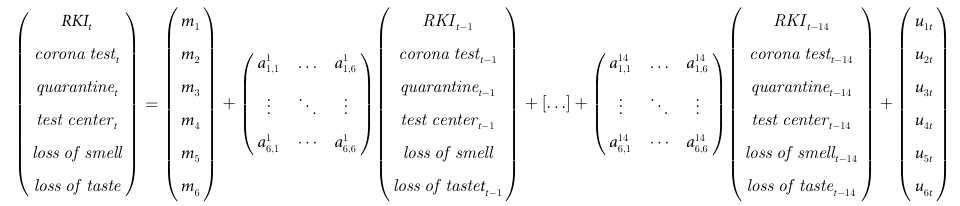
Table 3. Results Granger causality test.